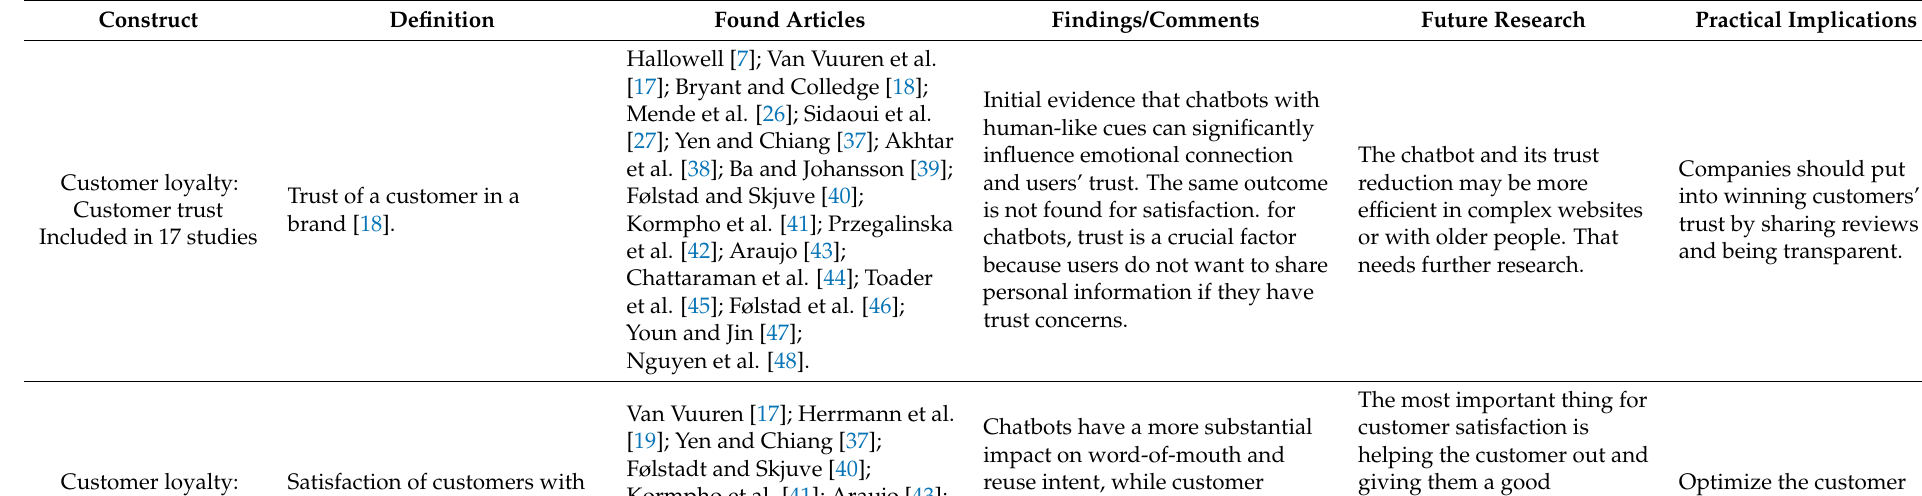
Table 2. Customer loyalty and chatbots construct